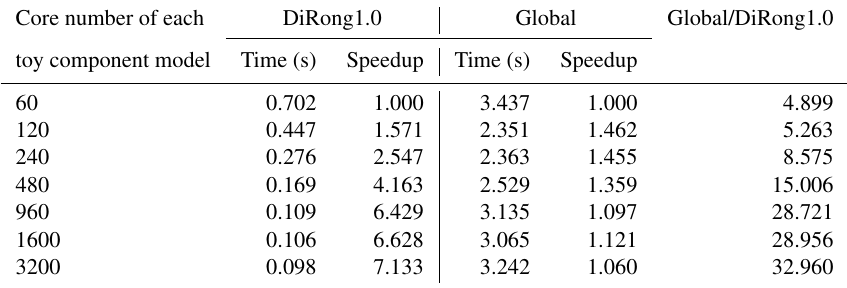
Table 9. Performance of DiRong1.0 and the comparison with the original global routing network generation (Global) using different numbers of cores numbers and the grid size of